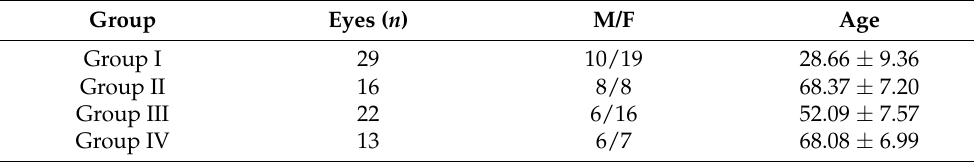
Table 1. Characteristics of all subjects.